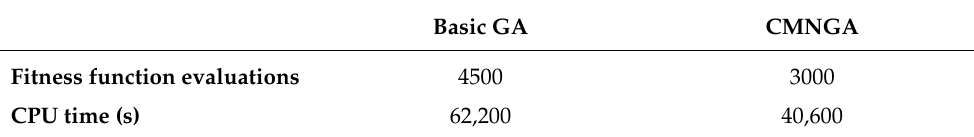
Table 11. Computational time and fitness function evaluation comparison for both GA used.